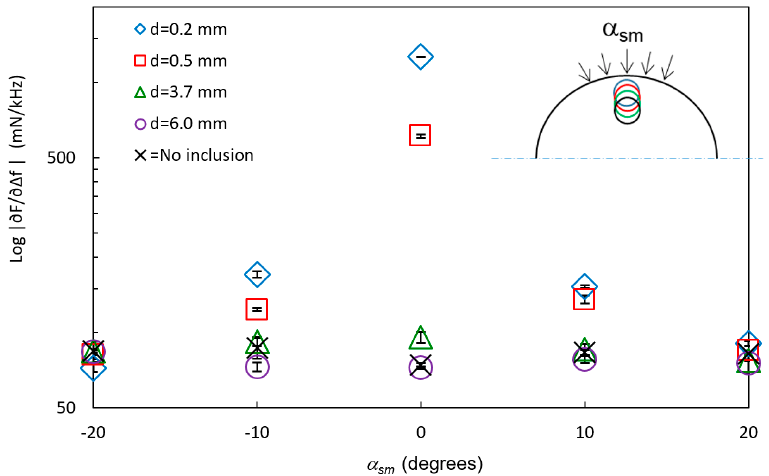
Figure 6. The logarithm of the stiffness parameter log | ∂ F / ∂ ∆ f | (mean ± SD, n = 6) at different angles of sensor movements α sm (see insert) on silicone spheres with inclusions with the diameter D = 6 mm but at different depths, d . Measurements made between the inclusions are marked “No inclusions”. The standard deviations (SD < 8.4 mN/kHz) are included in the graph.